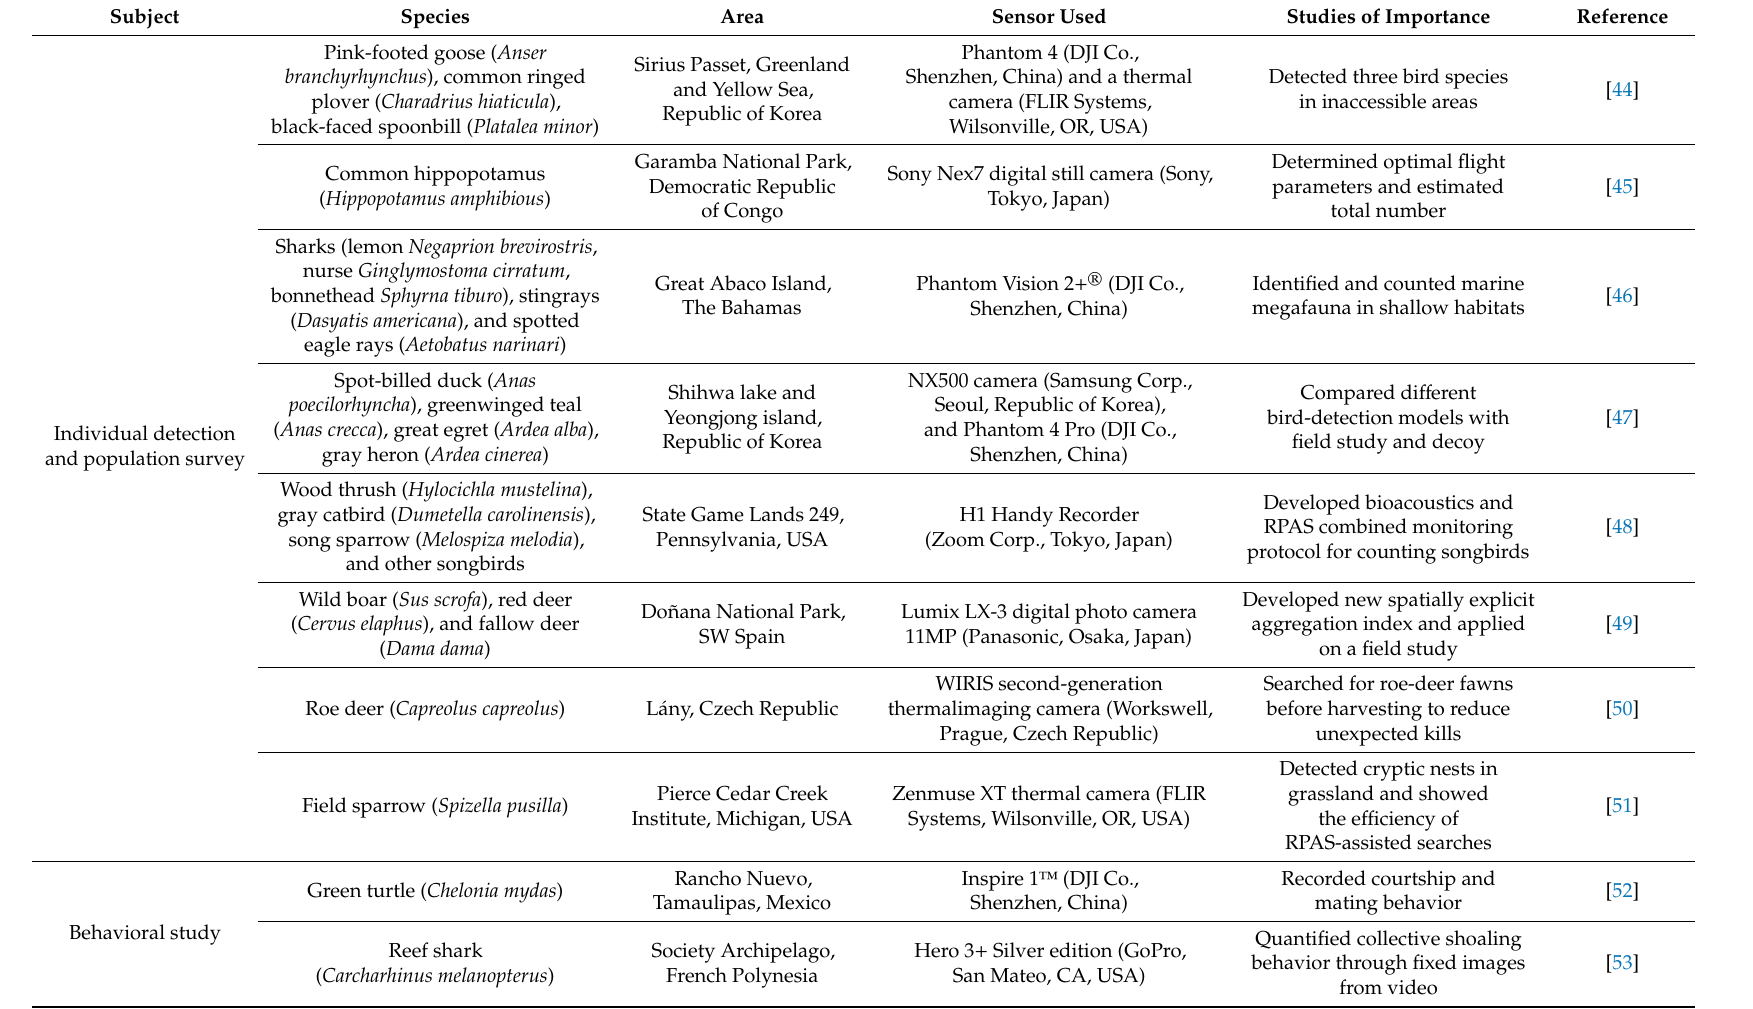
Table 2. Selected applications of RPAS on wild animal